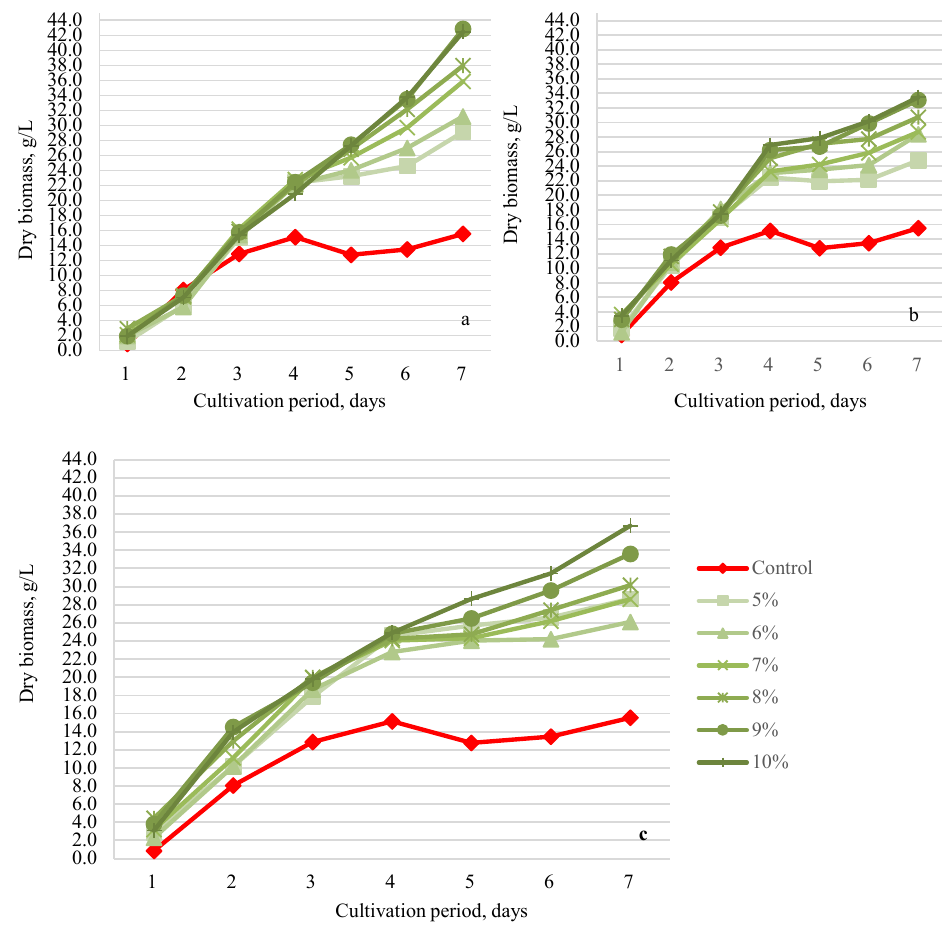
Fig. 4. R. glutinis biomass weight during cultivation period for samples with 5–10 % concentration of: a) Tween 20; b) Tween 40; c) Tween 80 supplementation compared with control without polysorbate.